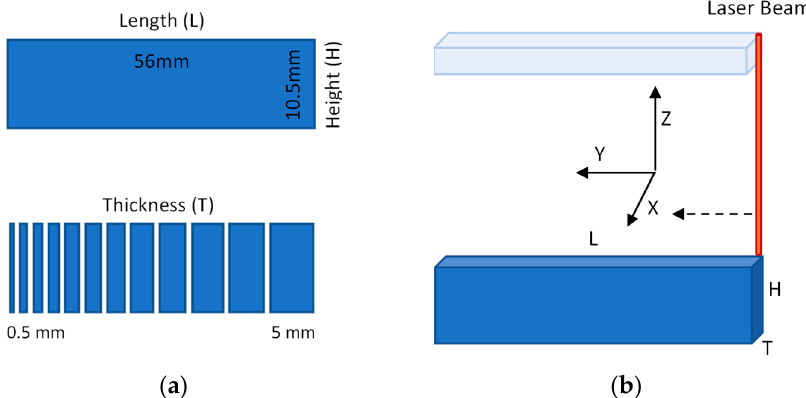
Figure 3. ( a ) Sample sizing and analyzed dimensions length (L), height (H), and thickness (T). ( b ) Sample build-up scheme.